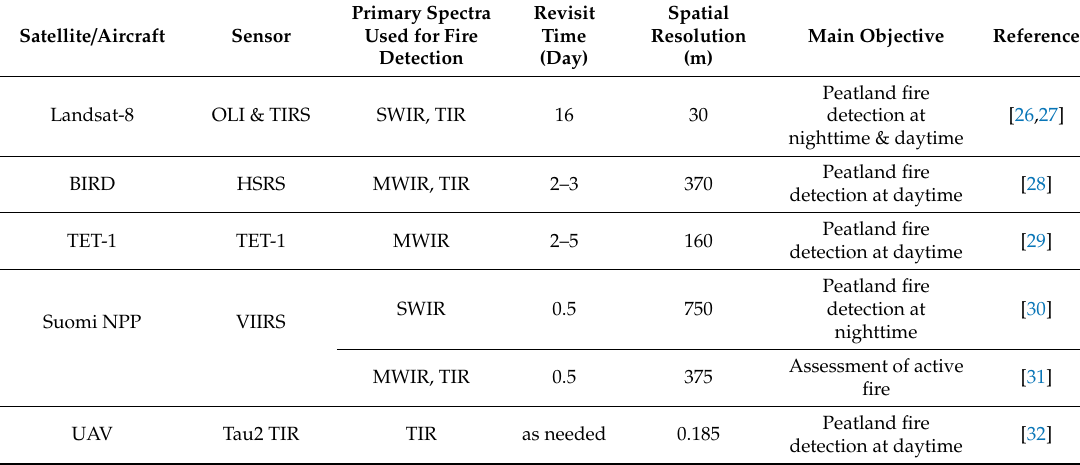
Table 1. List of peatland fire detection research using medium to low spatial resolution satellite data and unpiloted aircraft in Indonesia (OLI is Operational Land Imager; TIRS is Thermal Infrared Sensor; BIRD is Bi-spectral InfraRed Detection; HSRS is HotSpot Recognition System; TET-1 is Technology Experiment Carrier; Suomi NPP is Suomi National Polar-orbiting Partnership; SWIR is shortwave infrared; TIR is longwave thermal infrared; MWIR is mid-wave infrared; VIIRS is Visible Infrared Imaging Radiometer Suite; UAV is Unpiloted Aerial